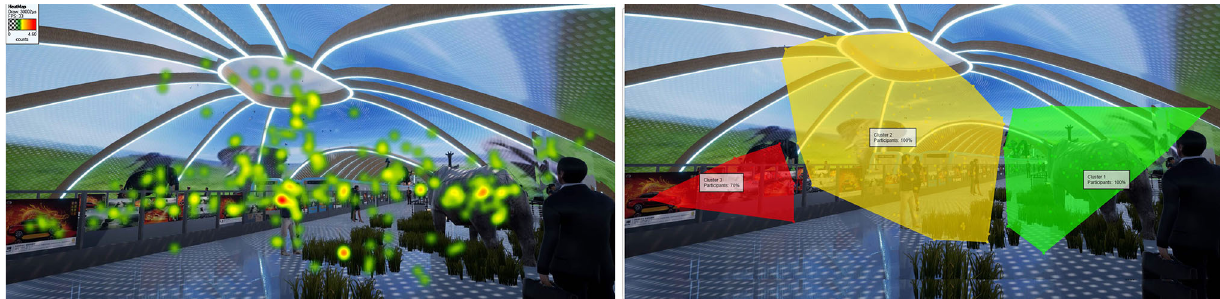
Fig. 5 Heat map and area of interest generated using VR with integrated ET. By Dongrui Zhu